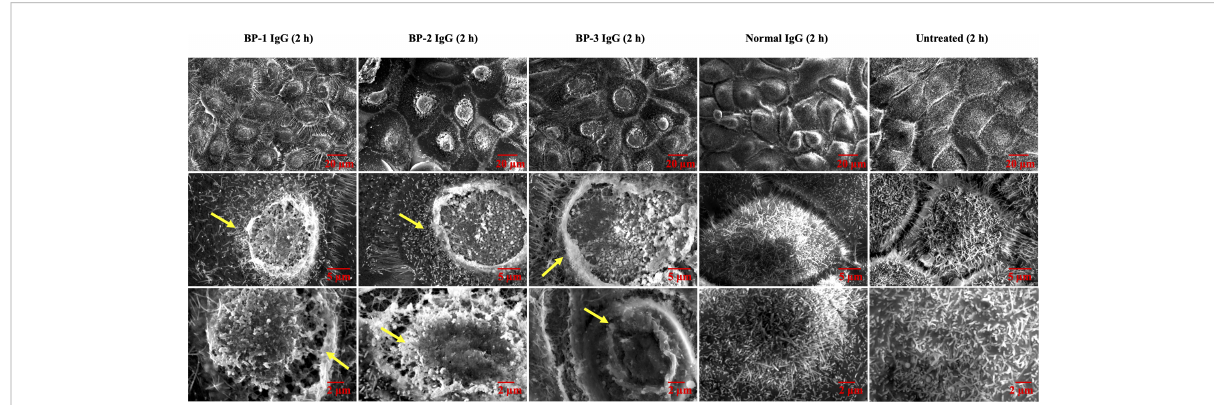
FIGURE 4 SEM images of NHEKs stimulated with BP IgG. SEM images of NHEKs treated with BP IgGs (BP-1, BP-2, and BP-3) or normal IgG for 2 h. The lower magni fi cation pictures show the connections of cells and fi lopodia. The higher magni fi cation pictures show the cell surface and microvilli of individual cells. The alterations in the cell membrane structure are indicated with